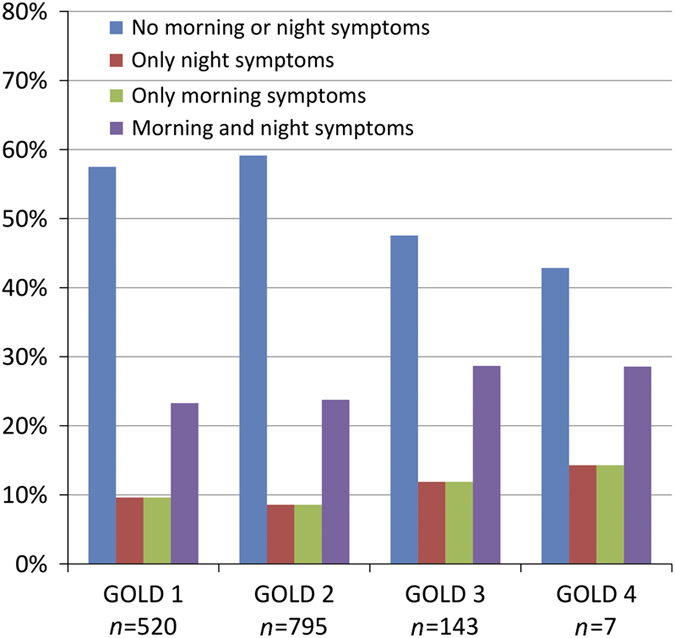
Percentages of patients with no morning and night symptoms, only night or morning symptoms and patients with both morning and night symptoms within the GOLD 1,2,3,4 categories.